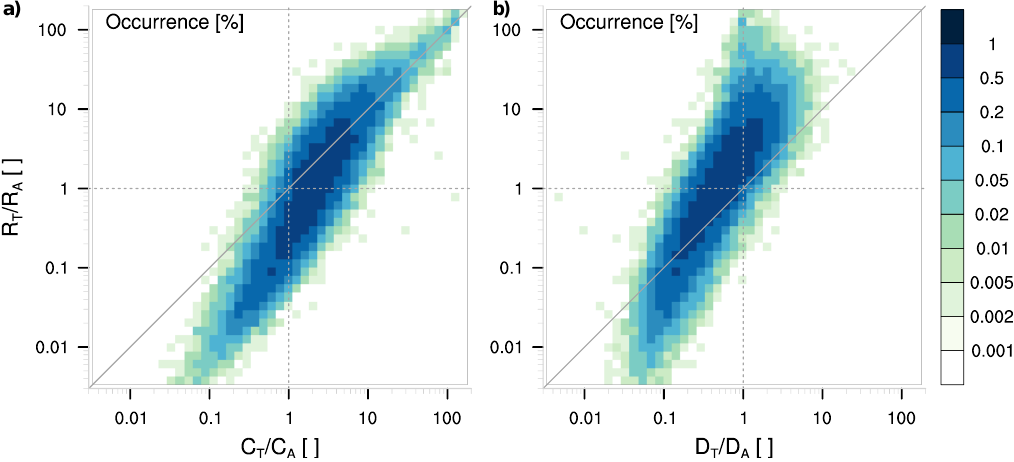
Figure 3. ( a ) 2D histogram with relative occurrence in % of all 40,538 hit cases shown as colors of average rain-rate ratio R T as a function of the rain coverage ratio C T R A ratio D T . Solid gray 1-by-1 line marks maximum possible dependence of R T D A while the other ratio needs to be 1 (gray dotted lines) because of C T